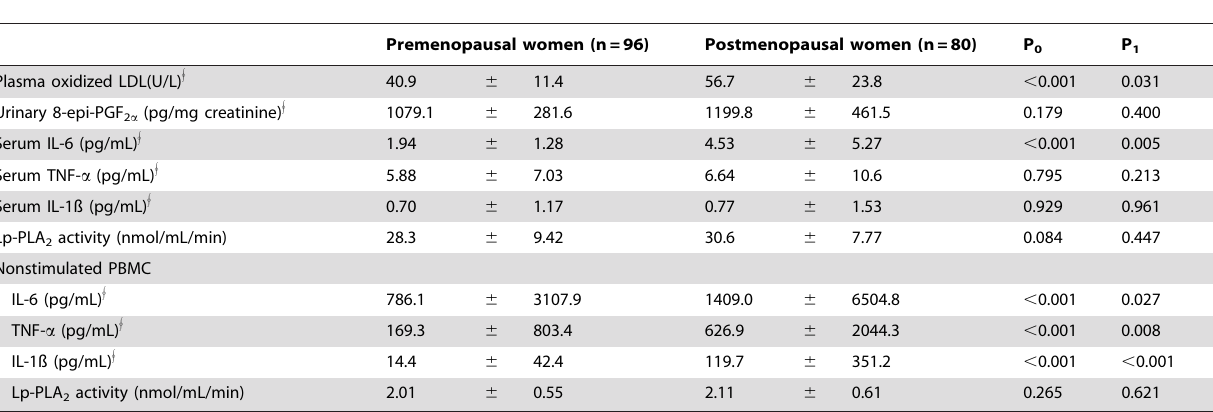
Table 2. Oxidative stress markers, cytokines, and Lp-PLA 2 activity according to menopausal